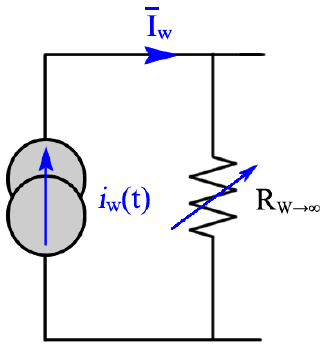
Figure 5. Electric circuit model for wind flow.